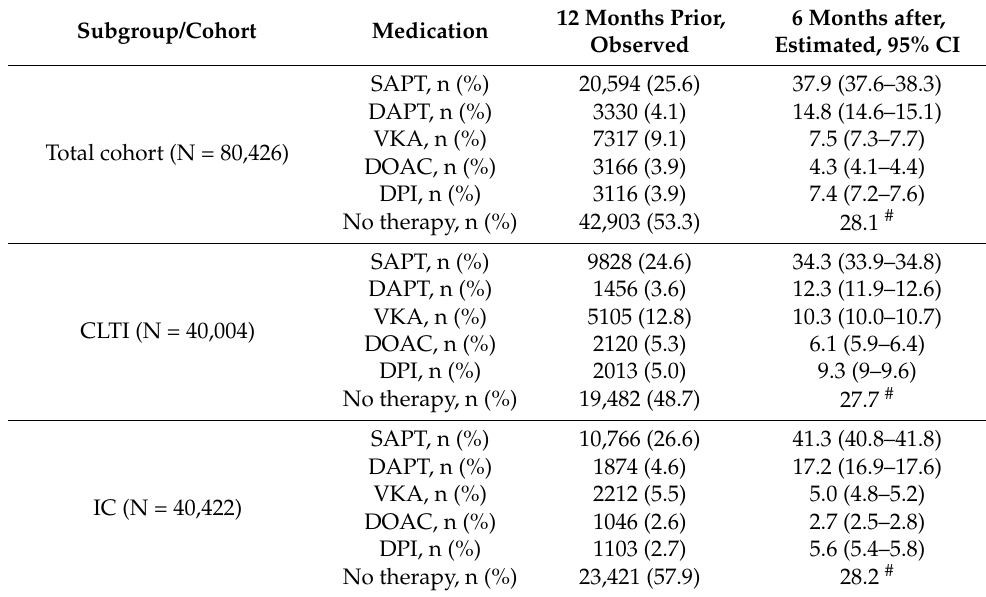
Table 2. Observed and estimated treatment patterns of the total study cohort, CLTI and IC